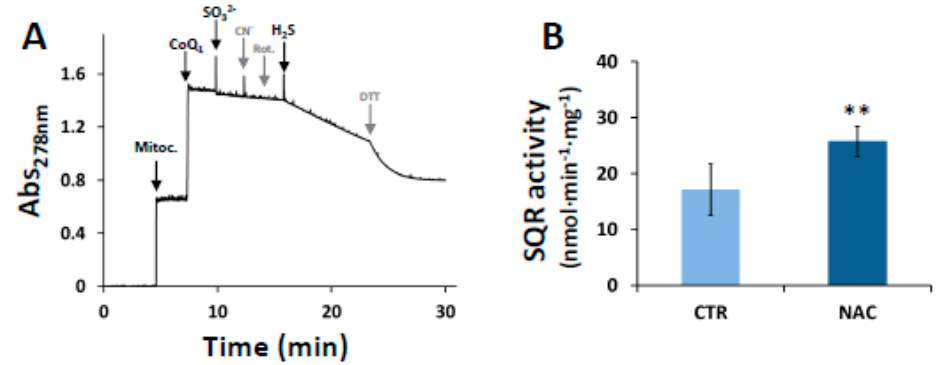
Figure 3. SQR activity of mitochondrial extracts. (Panel A ) Representative spectrophotometric trace of SQR activity. The measurement was carried out at 37 ◦ C under stirring. The starting solution contained the mitochondrial protein extract in 100 mM potassium phosphate bu ff er (pH 7.5) in anaerobic conditions (see Materials and Methods). Then, 58 µ M CoQ1, 1 mM sodium sulfite, 2 mM sodium cyanide and 4 µ M rotenone were sequentially added. SQR enzymatic activity was triggered by adding 96 µ M H 2 S, and the reaction rate was estimated by following the reduction of CoQ1 at 278 nm. Afterwards, CoQ1 was fully reduced by addition of dithiothreitol (DTT). (Panel B ) SQR activity normalized to total protein. Data represent the mean value ± SD of 5 repeats. ** p ≤